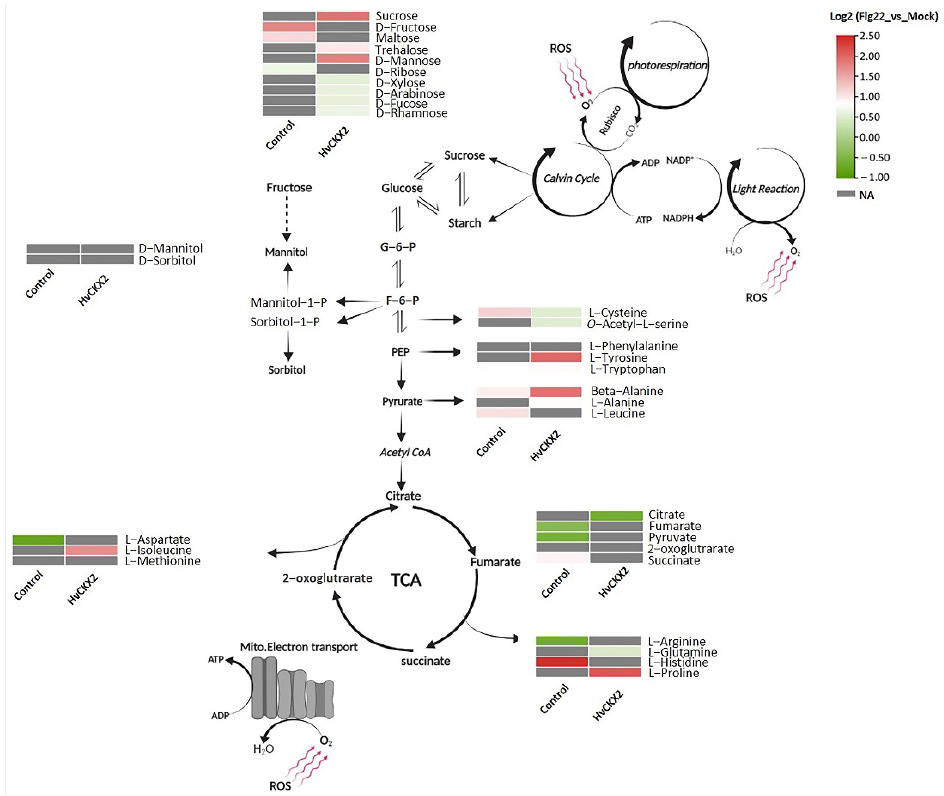
Figure 5. Diagram highlighting the metabolic changes observed in Arabidopsis HvCKX 2 and Col-0 plants 24 h after treatment with 1 µM flg22. The heatmaps show the log2-fold changes in the concentration of each metabolite between control and flg22-treated plants of both genotypes. Metabolites with no statistically significant changes are shown in grey (NA—not affected).